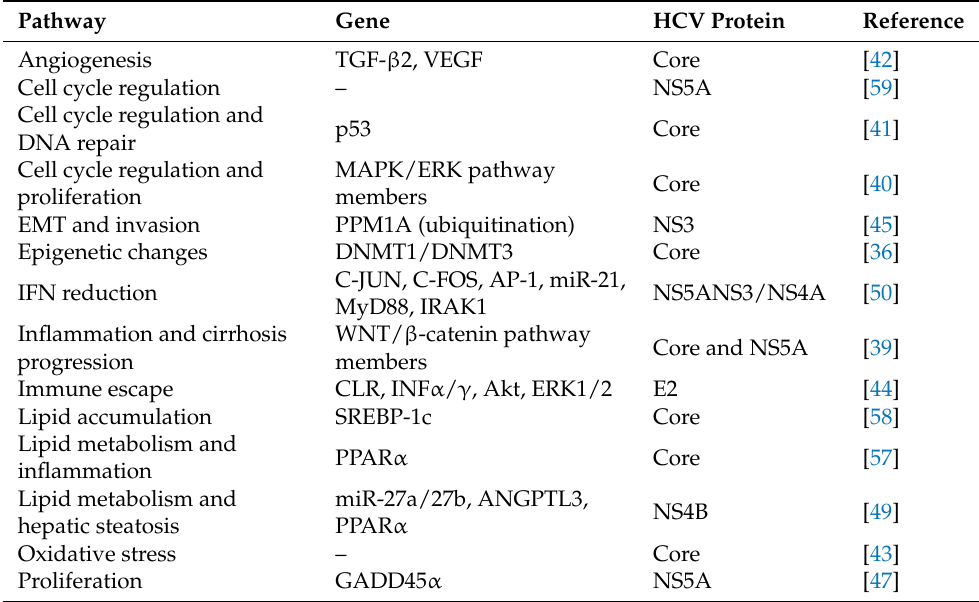
Table 3. HCV proteins contribute to the development of malignancy by modulating cellular gene expression and